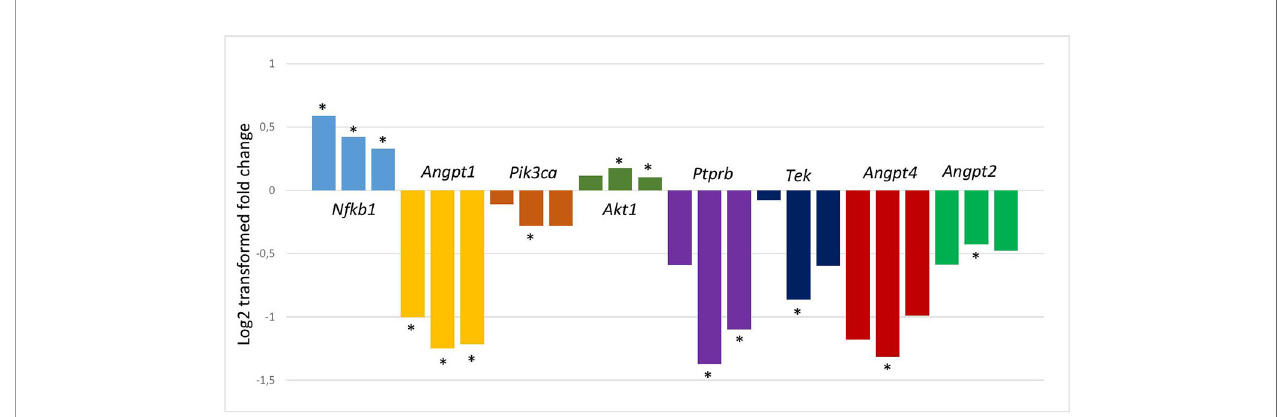
FIGURE 2 | LogFC values of the changes in gene expressions relative to controls. Only those genes are depicted whose expression showed at least one signi fi cant change in their expressions during the process leading to Th2-type allergic airway in fl ammation and hyperresponsiveness in a mouse model of asthma. After intraperitoneal sensitization with OVA on day 0 and 14 on days 28, 29, 30, and 31 mice were placed in a plastic chamber and challenged with OVA aerosol (in PBS) or PBS only (controls) for 20 min by an ultrasonic nebulizer. On day 28, 30, and 31, 4 h after the allergen challenge, in groups 1, 2, and 3, respectively, mice were anaesthetized, and the lungs were removed for gene expression analysis. The measurements were carried out by Agilent Whole Mouse Genome Oligo Microarray 4x44K chips. The results were deposited in GEO database with a record number of GSE11911 (GSE11911 - GEO DataSets - NCBI). *Indicates signi fi cant